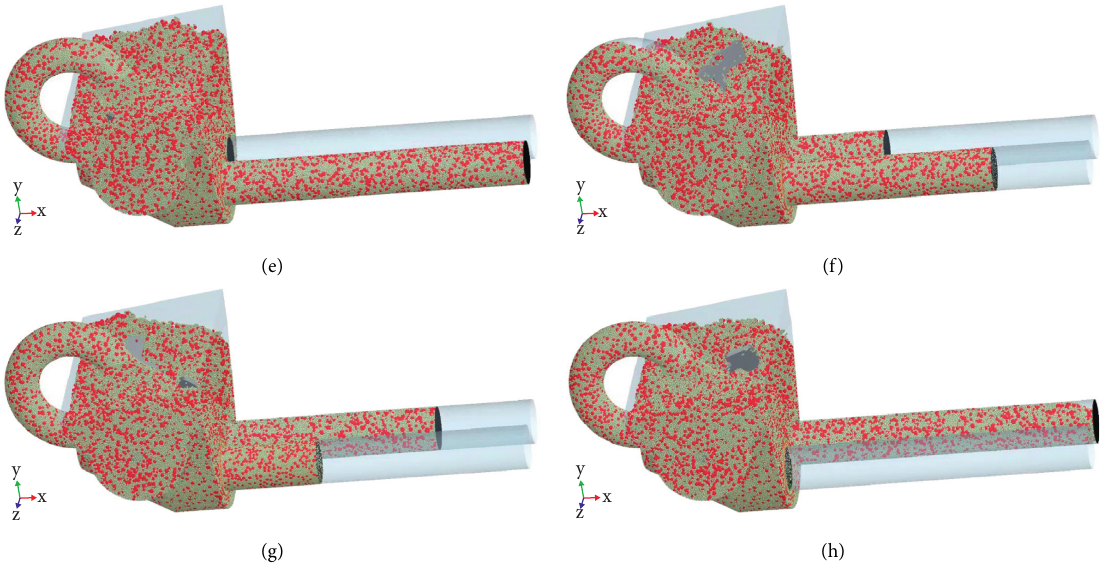
Figure 11: The numerical simulation visualization process of the second pumping cycle (4.1–7.7s): (a) t � 4.1s, (b) t � 4.6s, (c) t � 5.2s,